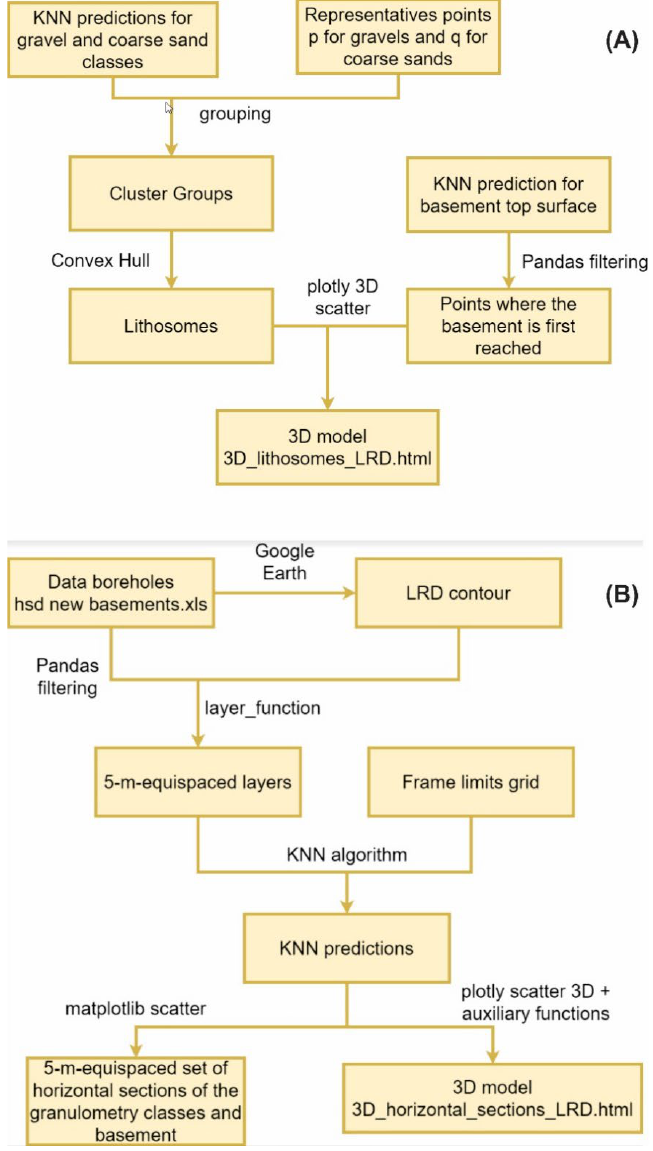
Figure 2. Flow diagram showing the methodological stages developed by Bullejos et al. [18] to create interactive 3D models of essential stratigraphic elements in the onshore LRD. The stages include data compilation and software implementation for the 3D mapping of ( A ) consecutive horizontal sections (5 m equispaced) of the grain-size classes generated by the KNN algorithm from 0 to 120 m b.s.l., and ( B ) coarse sedimentary bodies (lithosomes) and the basement top surface (the stratigraphic architecture) generated by Python